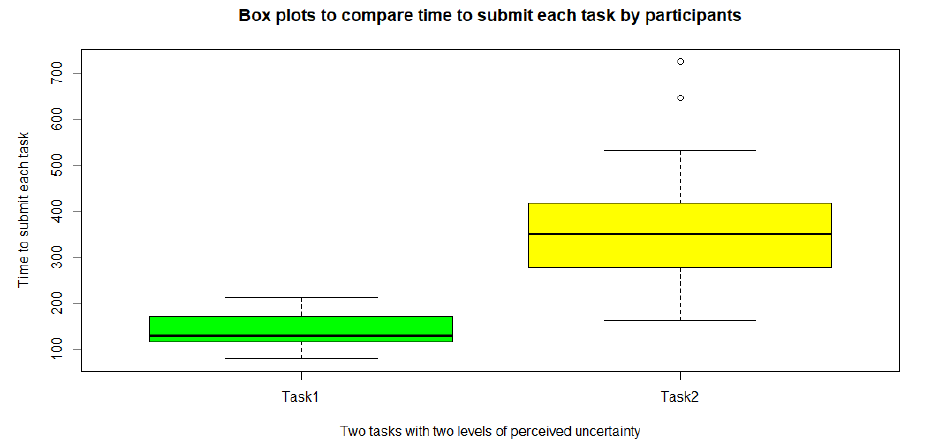
Figure 11. A comparison between the task time completion of the user for Task 1 and Task 2, measured in [s]. In these data, two completion time values identified as outliers which are shown in white circles in the